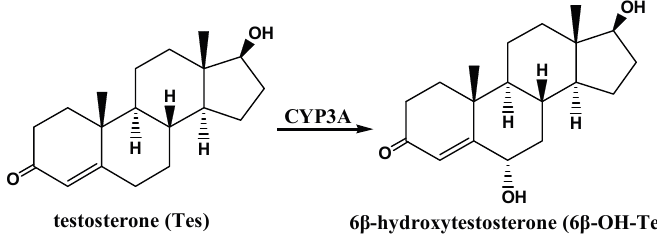
Figure 1. The major metabolic pathway of testosterone